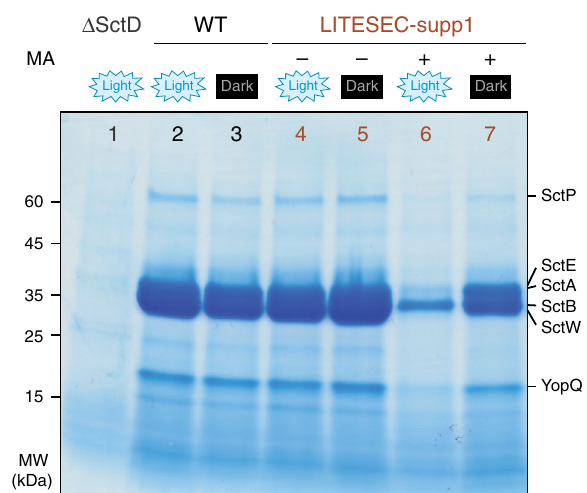
Fig. 3 Secretion of effector proteins by the type III secretion system can be controlled by light. In vitro secretion assay showing light-dependent export of native T3SS substrates (indicated on the right) in the LITESEC- supp1 strain. Proteins secreted by 3 × 10 8 bacteria during a 180-min incubation period were precipitated and analyzed by sodium dodecyl sulfate – polyacrylamide gel electrophoresis (SDS-PAGE). A strain lacking the membrane anchor (MA), the wild-type strain Δ HOPEMTasd and the T3SS-negative strain Δ SctD were used as controls. MW molecular weight in con fi rming the functionality of the used SctQ fusion protein. Strikingly, the LITESEC-supp1 system showed a high level of secretion when grown in the dark, but strongly reduced secretion when grown under blue light (Fig. 3, lanes 6, 7). To quantify the difference of secretion under light and dark conditions, we de fi ne the light/dark secretion ratio (L/D ratio) as the ratio of secretion ef fi ciency under light and dark conditions. For the LITESEC- supp1 system, the L/D ratio was 0.28, with normalized secretion ef fi ciencies of 23.5 ± 8.1% and 85.1 ± 5.1% in light and dark conditions, respectively.